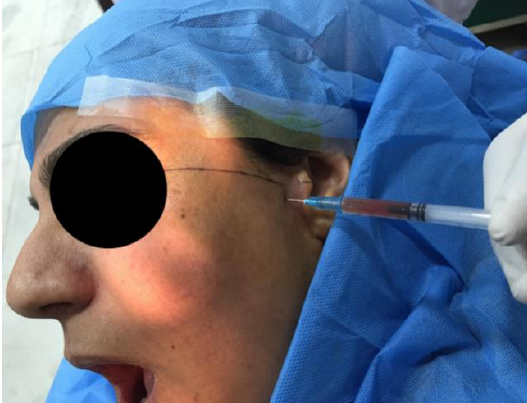
Figure 3: Illustrates the procedure for PRP injection.